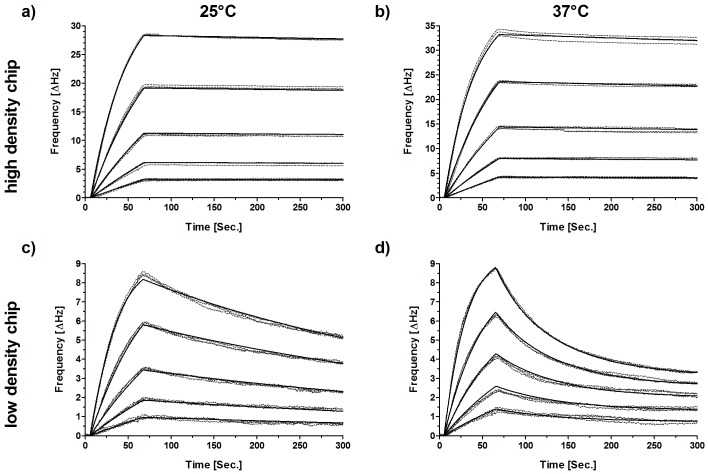
QCM analysis of human TNFR1 binding by ATROSAB.Binding of ATROSAB to human TNFR1 was analyzed by QCM at high (a, b; 130 Hz) and low (c, d; 27 Hz) density of immobilized human TNFR1-Fc. ATROSAB was analyzed at concentrations between 2–32 nM at 25°C (a, c) and 37°C (b, d) in triplicates for each concentration (dashed lines = data curves, solid lines = fitted curves).